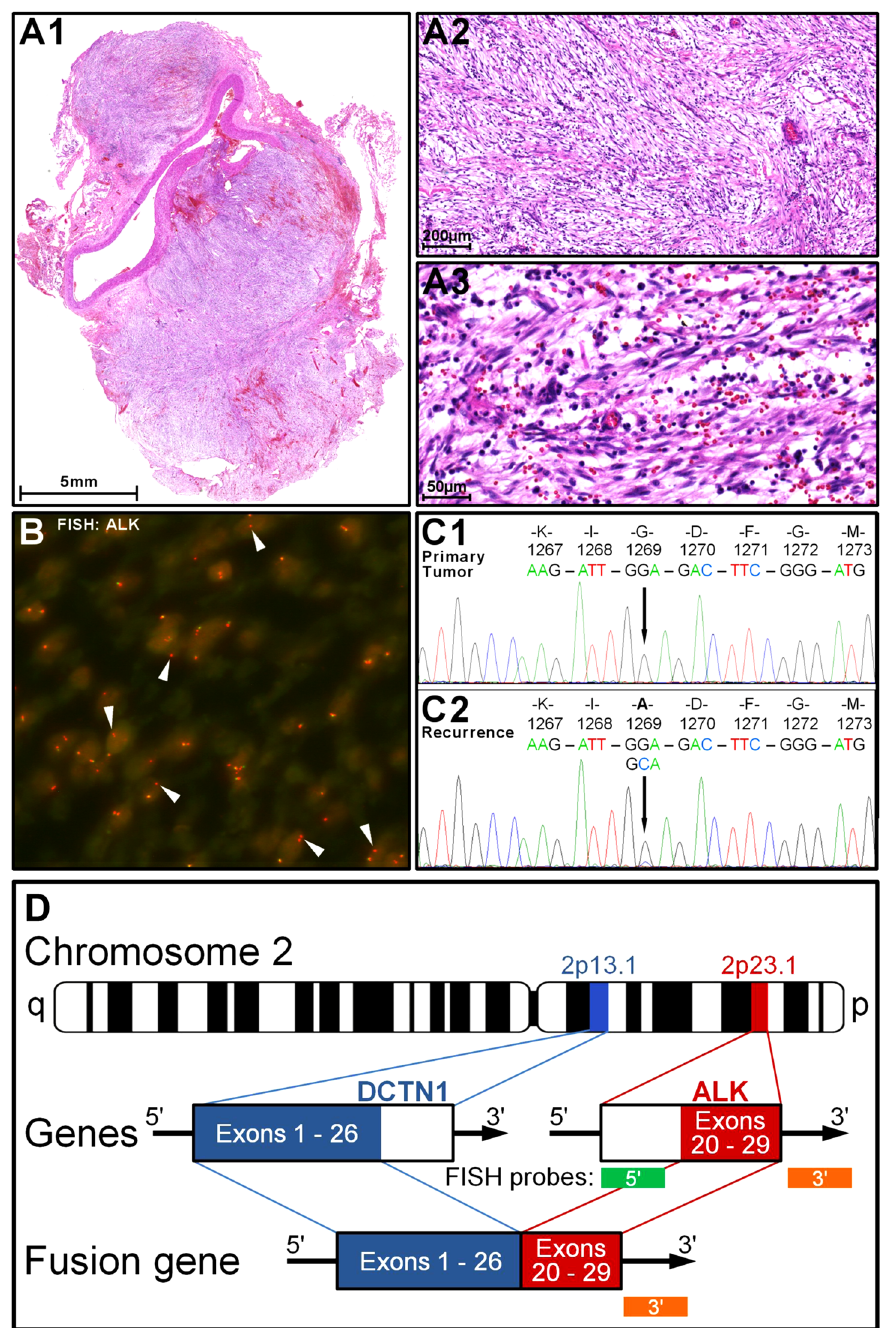
Fig. 1 a1 – a3 Hematoxylin and eosin stained section of IMT. b Fluorescence in situ hybridization of post-crizotinib sample tissue, con fi rming rearrangement of ALK in 2p23: Isolated red signals ( arrows ) indicate loss of the 5' region of ALK . Orange fusion signals of the red 3' probe and the green 5' probe indicate normal ALK alleles. c Sanger sequencing of ALK of the initial tumor sample (C1) and the post-crizotinib sample (C2) identifying the ALK G1269A resistance mutation. d Schematic illustration of the DCTN1-ALK fusion. Exons 20 – 29 of the ALK gene, which contain the tyrosine kinase domain, are fused with exons 1 – 26 of the DCTN1 gene. Both genes are located on chromosome 2p. The 5' region of ALK was apparently lost as indicated by the absence of the green FISH